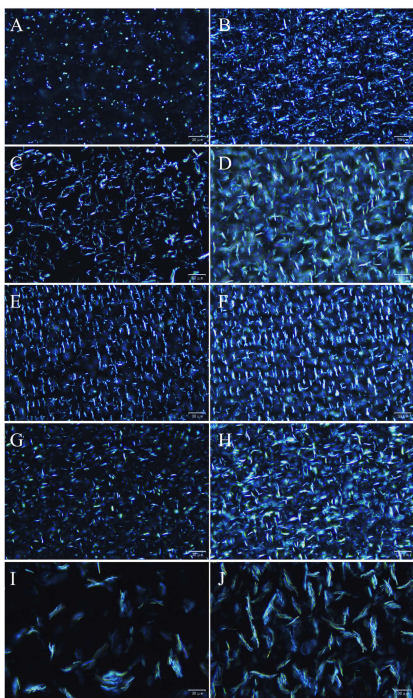
Figure 2. Polarized light microscopy images of CLW oleogels at critical ( A ) and 8 wt.% concentrations ( B ). Polarized light microscopy images of RBW oleogels at critical ( C ) and 8 wt.% concentrations ( D ). Polarized light microscopy images of CRW oleogels at critical ( E ) and 8 wt.% concentrations ( F ). Polarized light microscopy images of BW oleogels at critical ( G ) and 8 wt.% concentrations ( H ). Polarized light microscopy images of GMS oleogels at critical ( I ) and 8 wt.% concentrations ( J ). All images were taken at 40 × magnification at 25 ◦ C. Scale bar = 30 µ